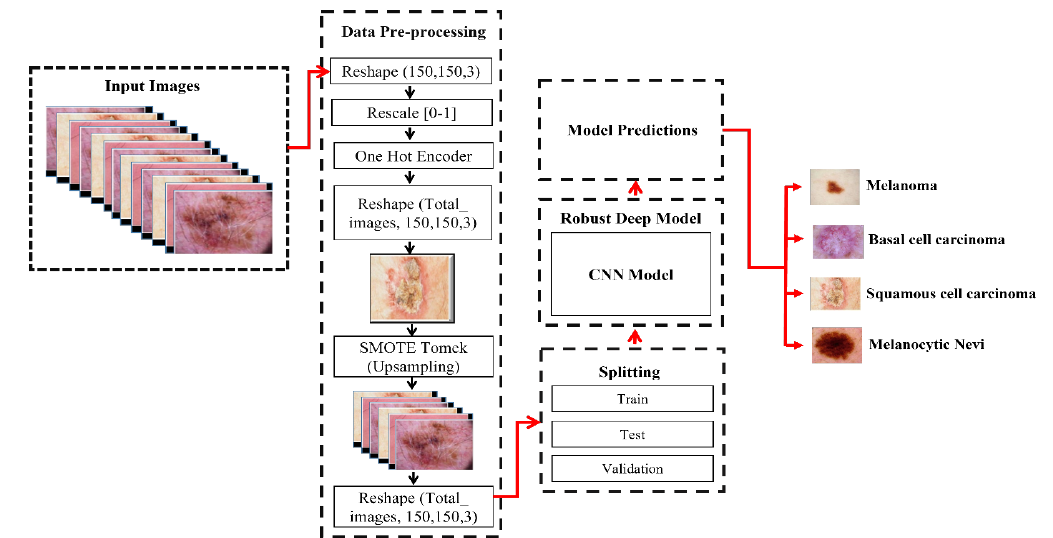
Figure 1. Workflow of the proposed DSCC_Net model.